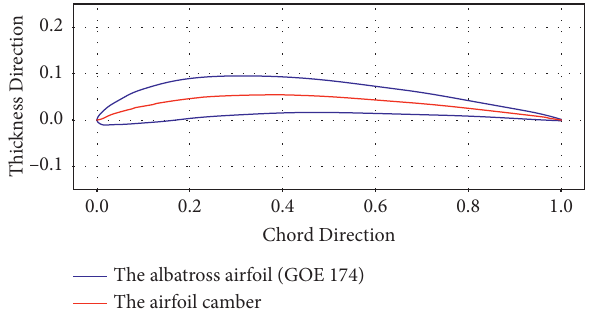
Figure 2: Views of the dimensionless albatross airfoil.